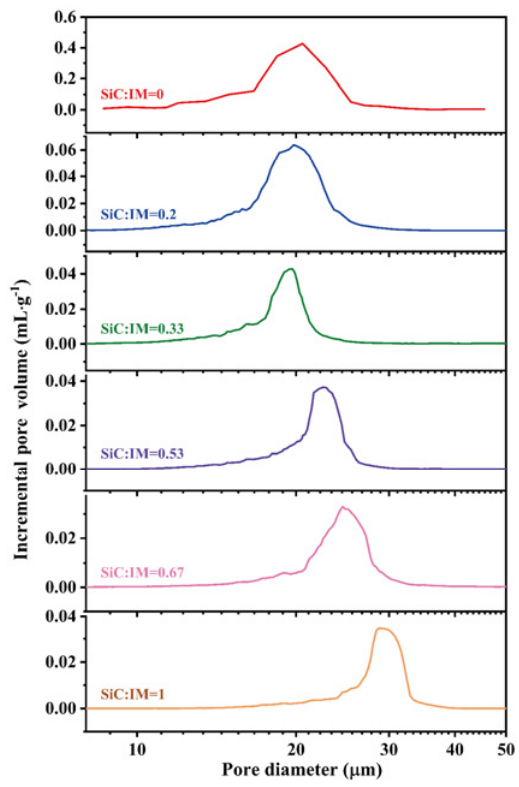
Fig. 8 Pore size distributions of C f /SiC/C green bodies.